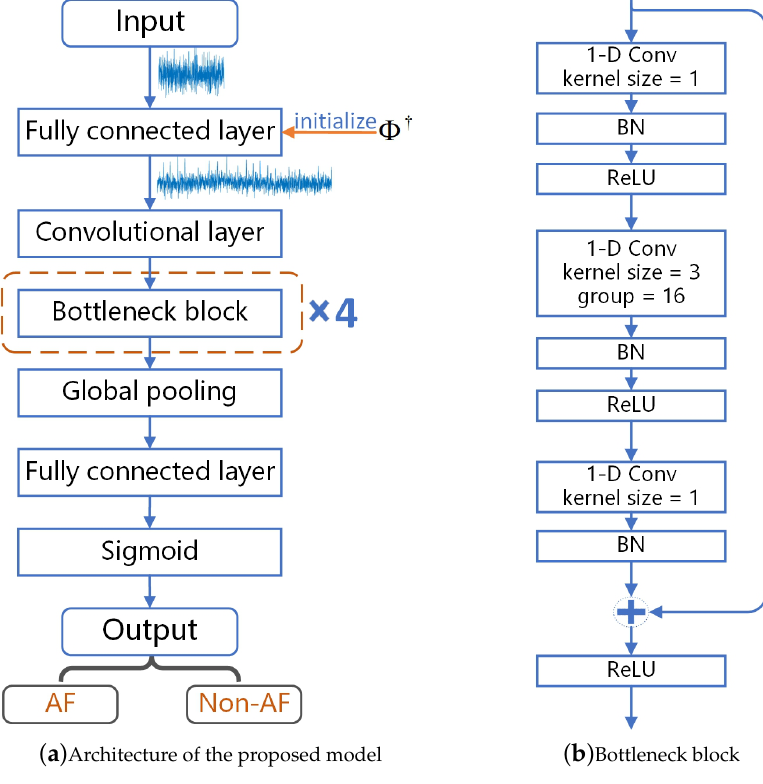
Figure 3. Proposed model for AF detection from compressed